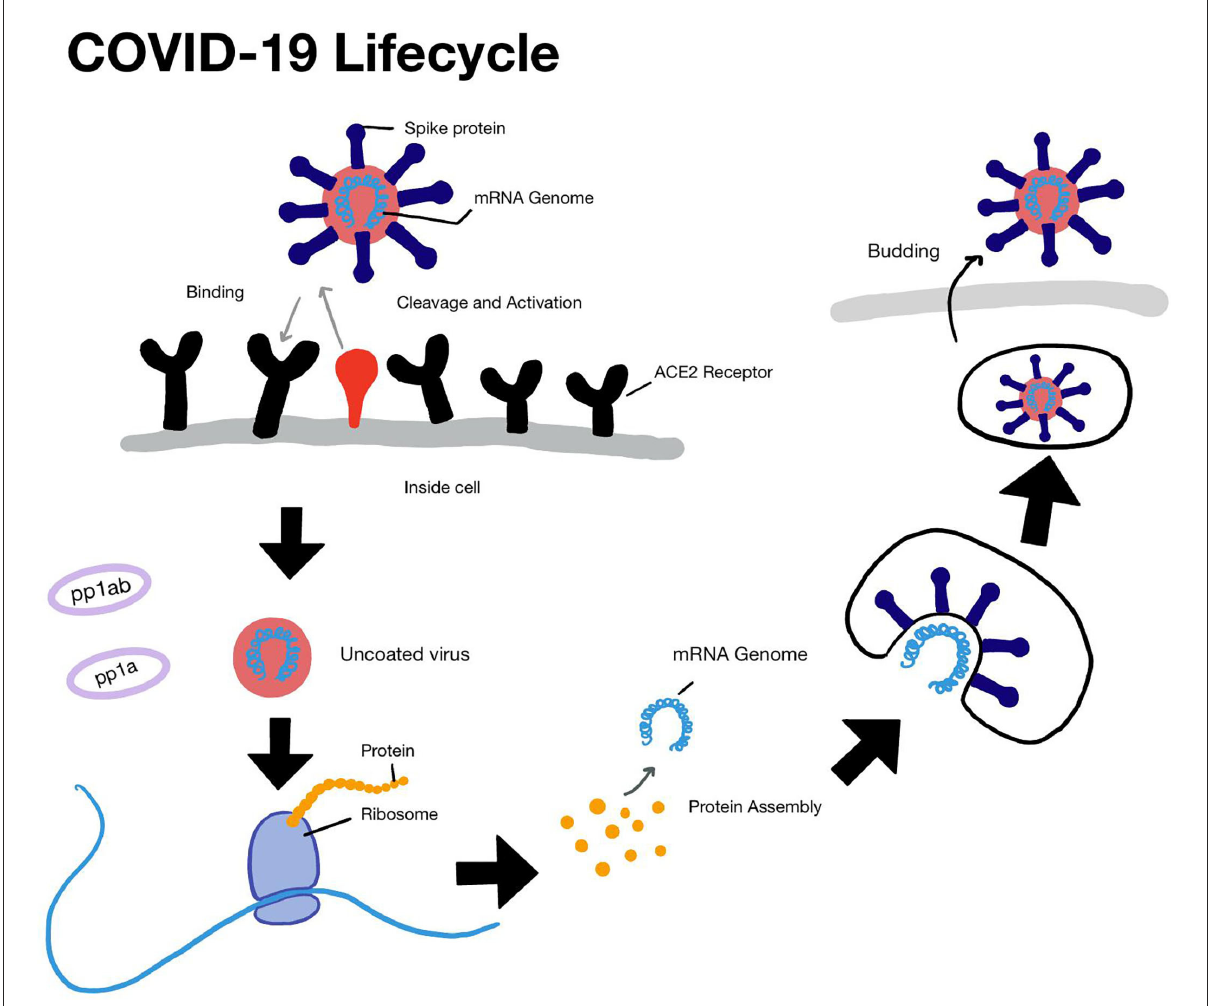
FIGURE1 The life cycle of SARS-COV2. The steps involved from entry to replication and budding are shown in this